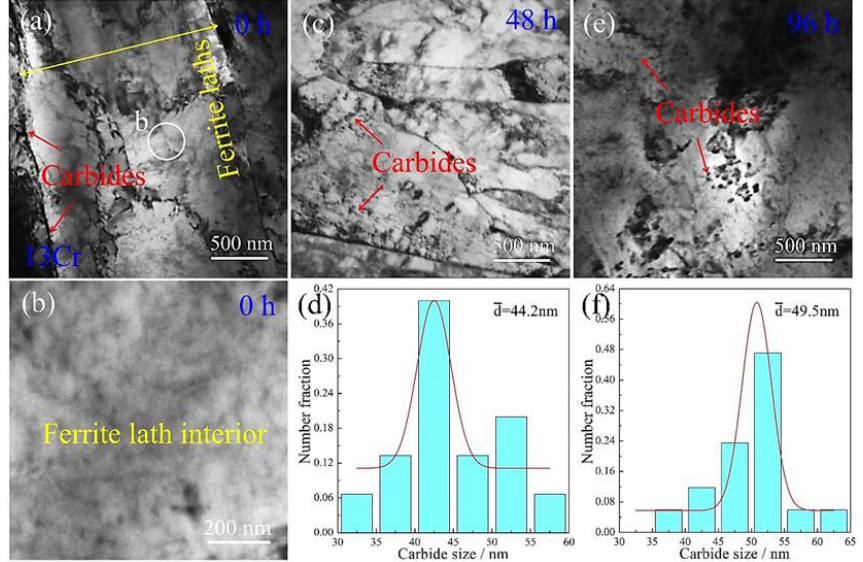
Figure 7. TEM images of the 13Cr samples crept for various durations: ( a , b ) 0 h; ( c , d ) 48 h and ( e , f ) 96 h. ( a ) BF image showing ferrite lath and carbides along the ferrite lath boundary; ( b ) close-up image of the circle in ( a ) showing the morphology inside the ferrite lath interior; ( c , e ) BF images of the samples crept for 48 h and 96 h, respectively; ( d , f ) corresponding statistical size distribution of carbides.